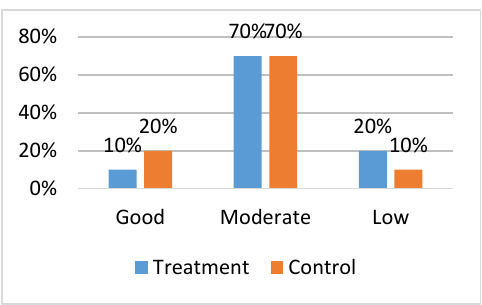
Figure 1 Self Care Ability Before Modeling Participants Treatment.